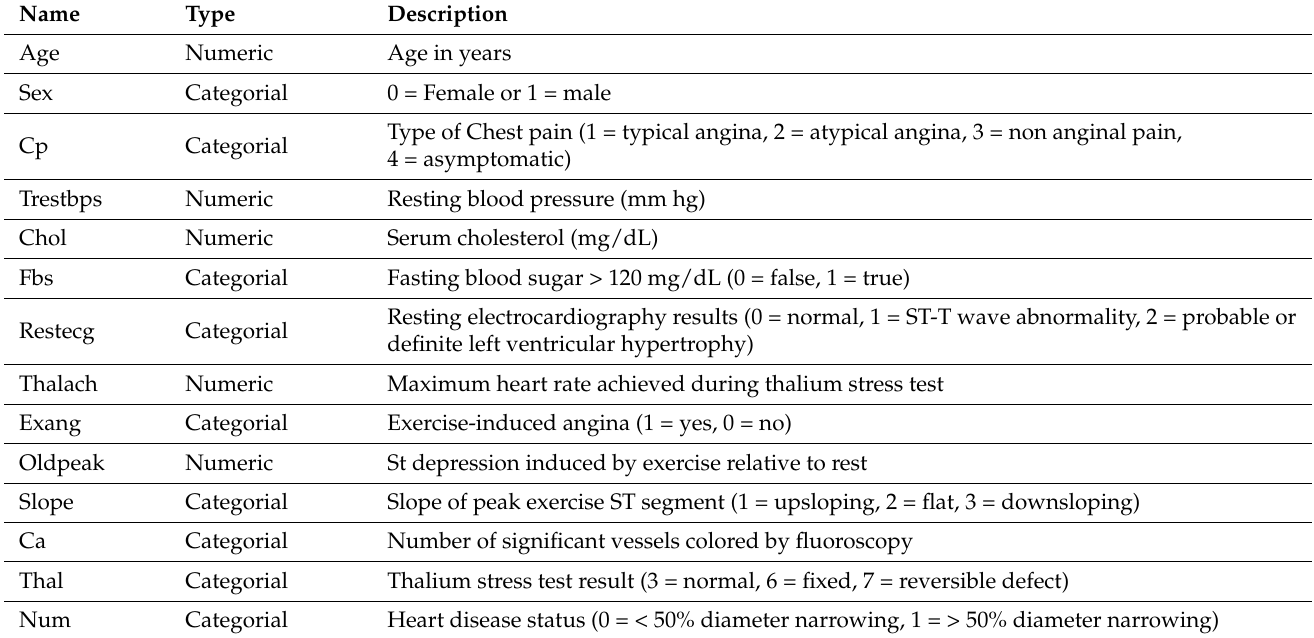
Table 1. Attribute descriptions of Cleveland datasets [19].